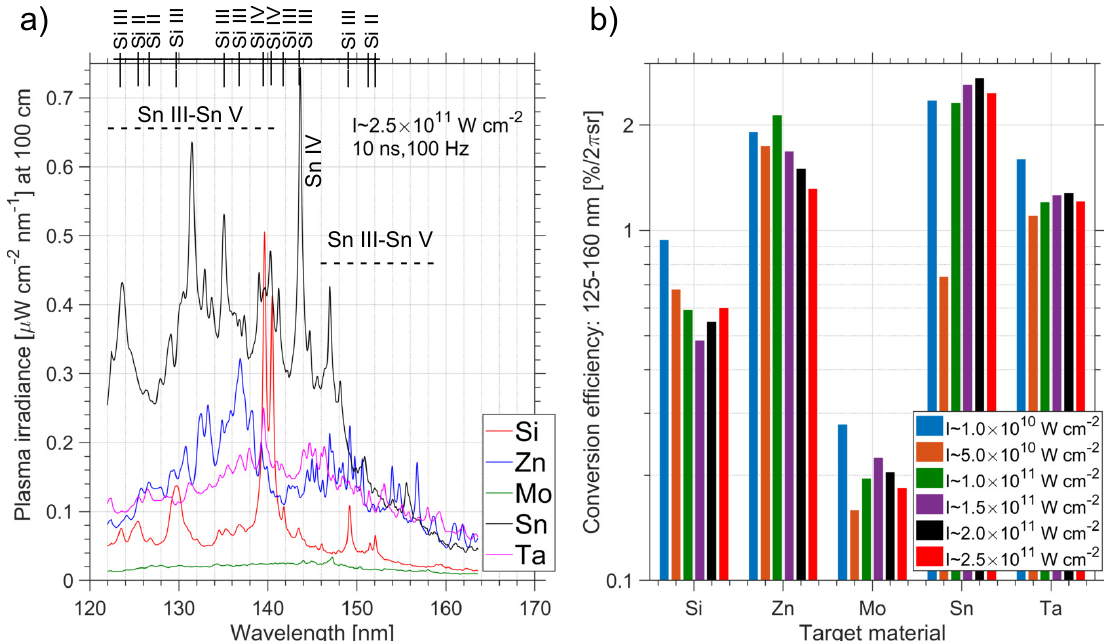
Figure 4. ( a ) Measured spectral irradiances of the Si, Zn, Mo, Sn and Ta plasmas at a distance of 100 cm from the target over the wavelength region of ≈ 123–164 nm. Here, a plasma generated by a 1.0 µ m, 100 Hz, 10 ns pulse at the laser irradiance of ≈ 2.5 × 10 11 W cm − 2 (pulse energy ≈ 230 mJ). The observed Si spectral lines are shown (on top) using the NIST database [22]; ( b ) measured radiation conversion efficiency (in units of % into 2 π sr) over the wavelength spectral band of 125–160 nm for various laser irradiances (pulse energies) of ≈ 10 10 ( ≈ 10 mJ), 5 × 10 10 ( ≈ 44 mJ), 1.0 × 10 11 ( ≈ 90 mJ), 1.5 × 10 11 ( ≈ 140 mJ), 2 × 10 11 ( ≈ 190 mJ) and 2.5 × 10 11 Wcm − 2 ( ≈ 230